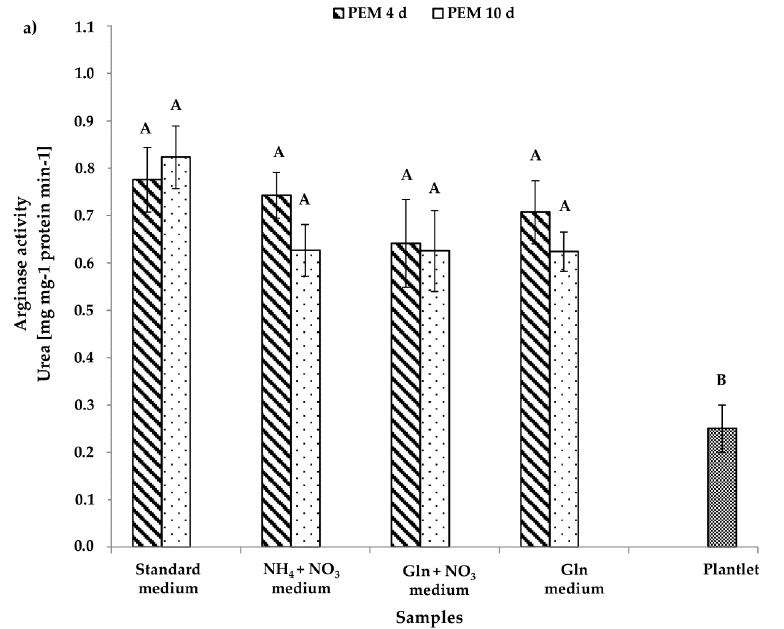
Figure 8. Arginase activity of PEMs and mature somatic embryos (MSE). ( a ) arginase activity of PEMs after 4 days (PEM 4d) and after 10 days (PEM 10d) on standard medium, NH 4 + NO 3 medium, Gln + NO 3 medium and Gln medium in comparison with somatic embryo-derived plantlets run as control; ( b ) arginase activity of mature somatic embryos generated on NH 4 + NO 3 medium, Gln + NO 3 medium and Gln medium in comparison with two-month-old somatic embryo-derived plantlets. Bars indicate standard errors. Different letters above the columns indicate significant differences based on the Tukey-Kramer HSD test, p ≤ 0.05.